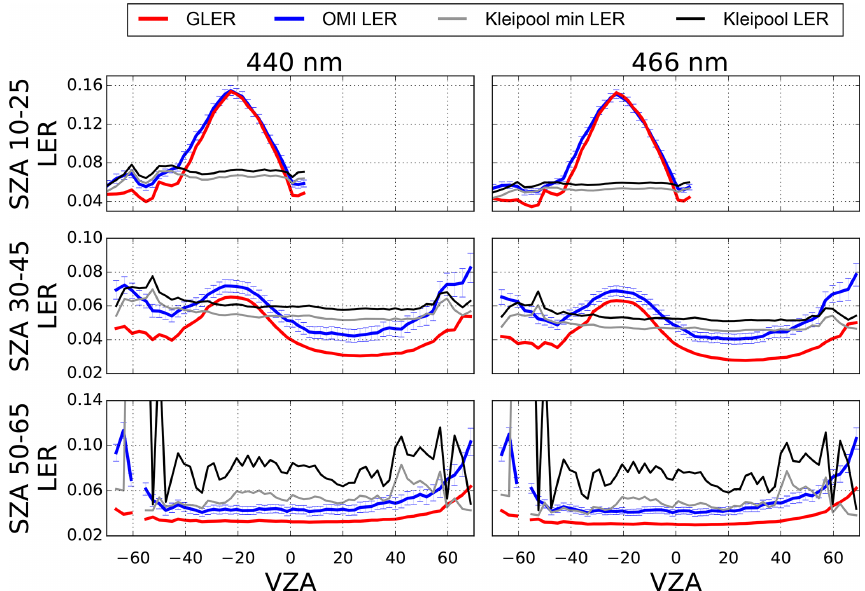
Figure 4. Same as Fig. 3 but for 440 and